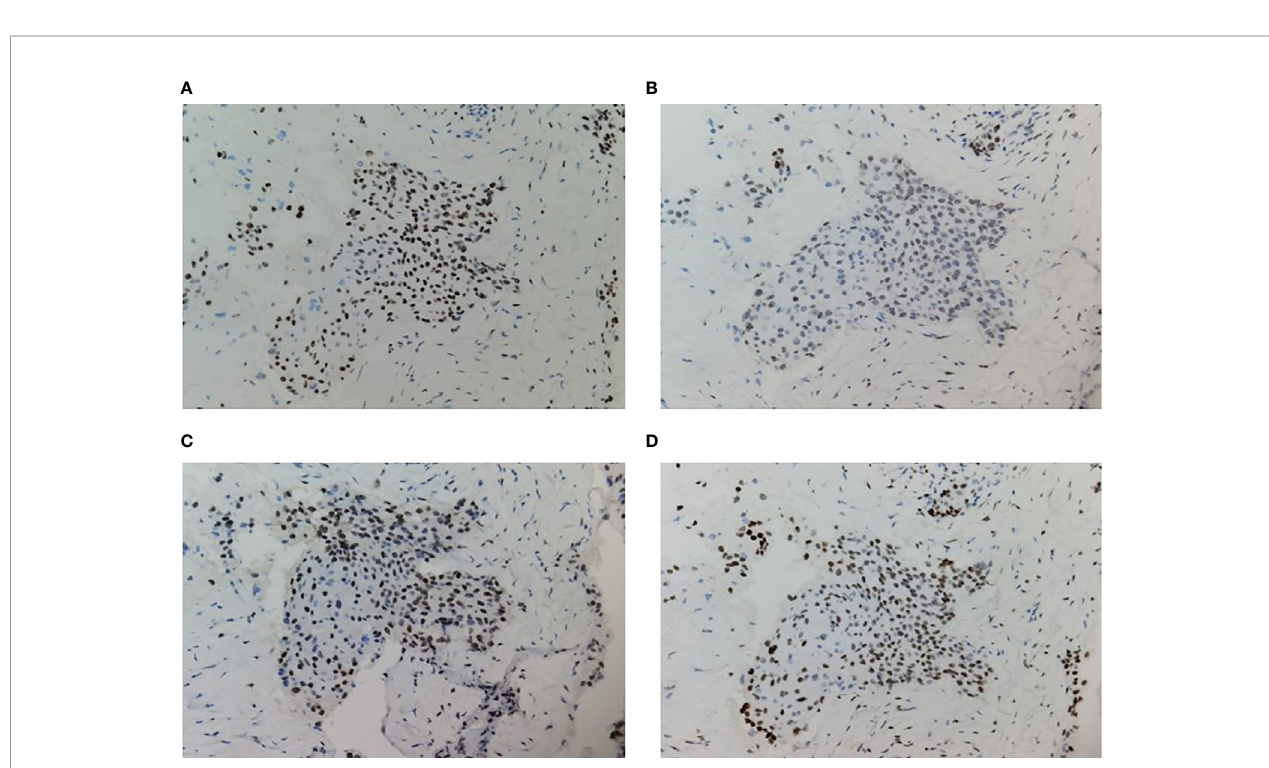
FIGURE 3 | Immunohistochemistry of MMR proteins. The tumor cells preserved expression of MLH1 (A) , MSH2 (B) , PMS2 (C) , and MSH6 (D) ; original magni fi cation